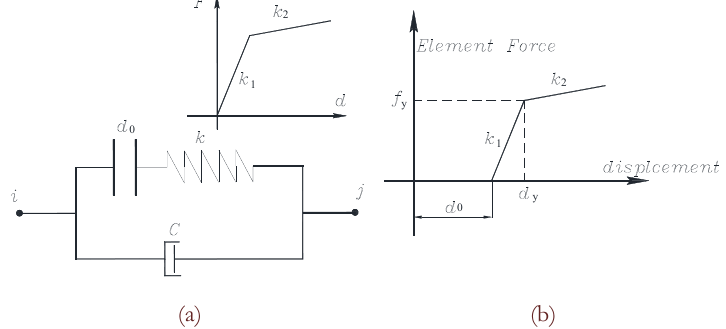
Figure 3: Contact element: (a) Mechanical model of the contact element; (b) Hysteresis curve of the contact